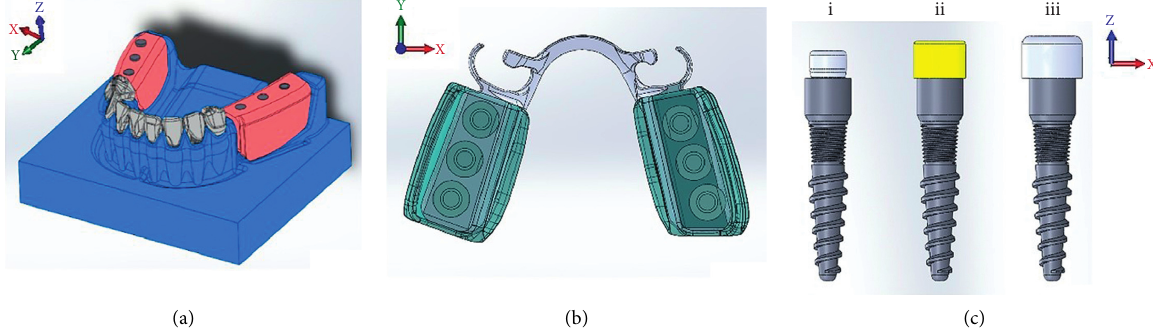
Figure 2: The separately prepared components of the FEA model: (a) the mandible with bilateral distal extension ridges, (b) the distal extension RPD metal framework with acrylic bases, and (c) mini dental implant connected with equator attachments.